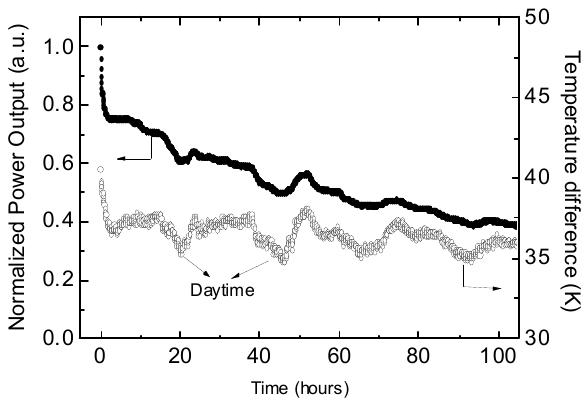
Figure 10. Power output of module and temperature difference as a function of the working time. Reproduced with permission from [68]. Copyright 2014 The Royal Society of